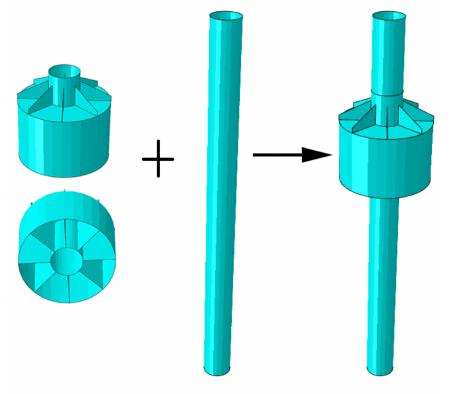
Figure 1. The geometry for the pile–bucket foundation; structural